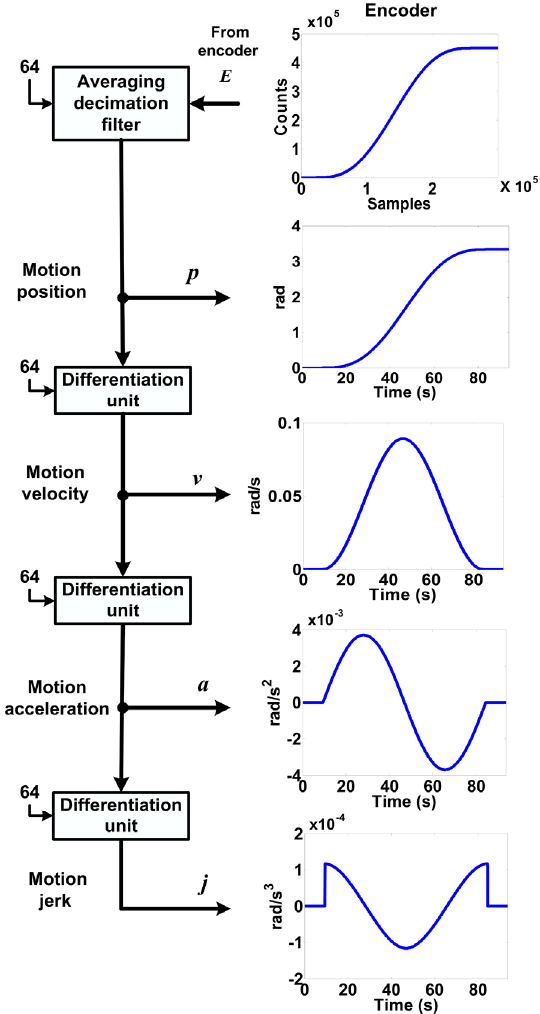
Figure 5. The motion dynamics